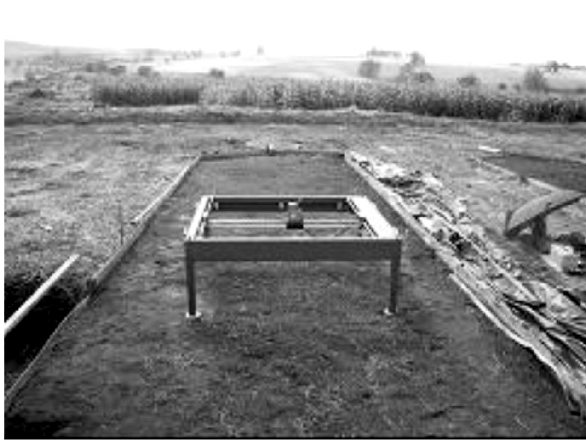
Table 1. Soil physical properties before the